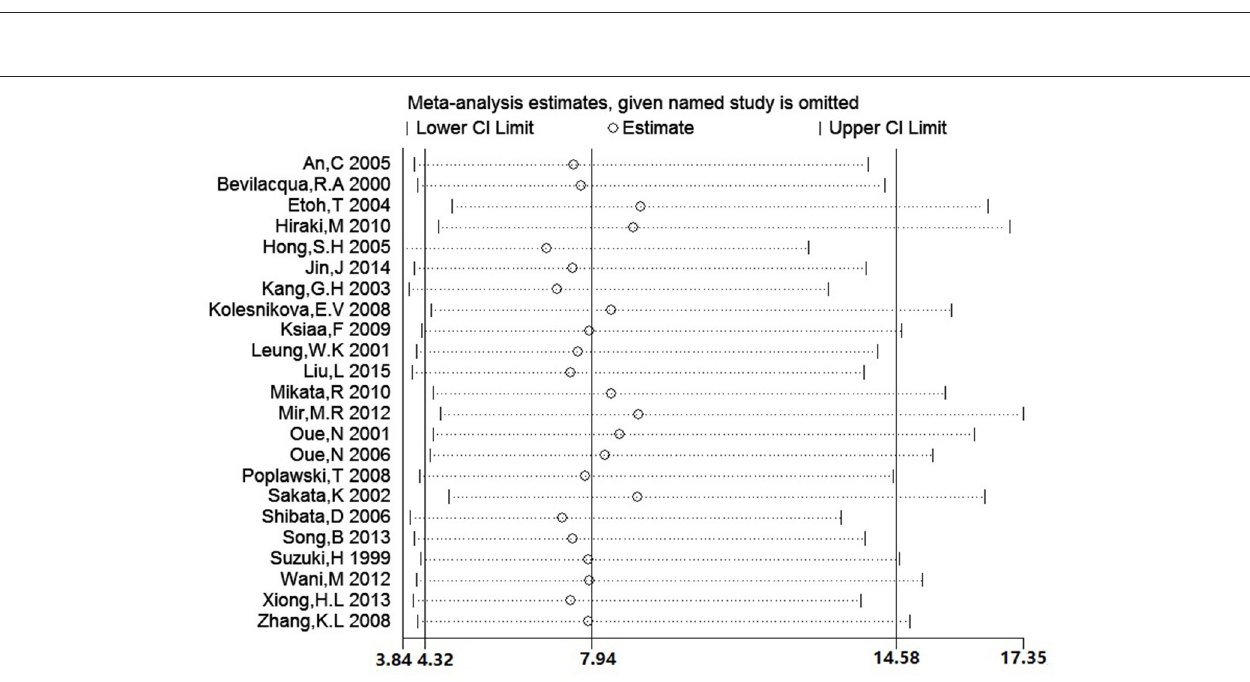
FIGURE 8 | The plot of sensitivity analysis for evaluating the association between hMLH1 methylation and gastric risk. The circle and horizontal dashed line represent the pooled OR and 95% CI after omitting the corresponding study.